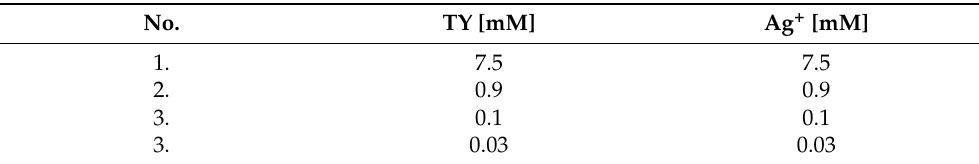
Table 1. Concentration of TY and Ag + in four samples obtained by the serial dilution (TY-Ag molar ratios was 1:1).